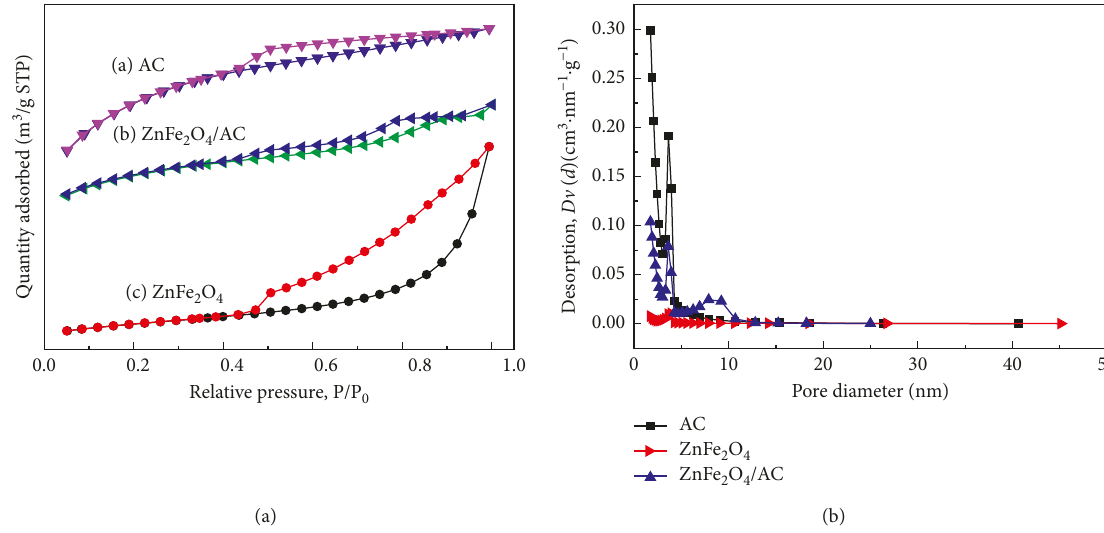
Figure 10: N 2 adsorption-desorption isotherms and pore size distribution of AC, ZnFe 2 O 4 , and ZnFe 2 O 4 /AC